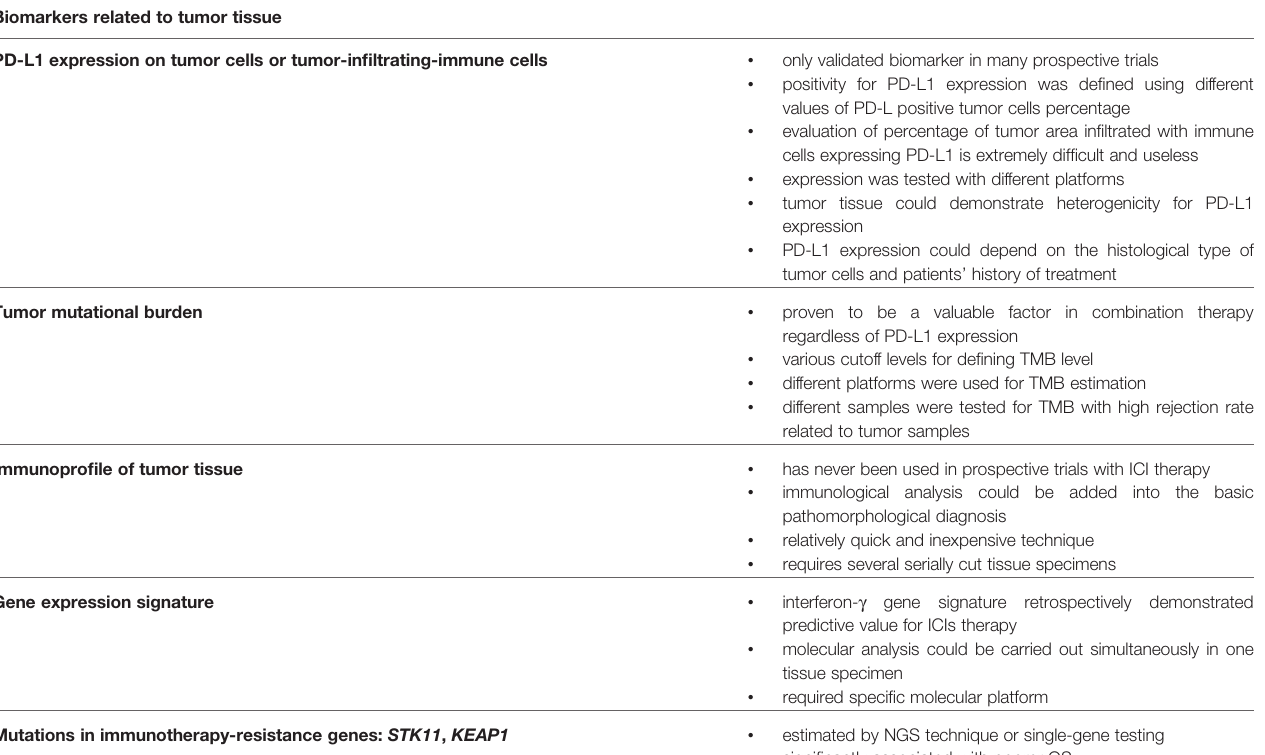
TABLE 1 | Summary of the most important advantages or disadvantages of the described biomarkers used in quali fi cation of NSCLC patients to